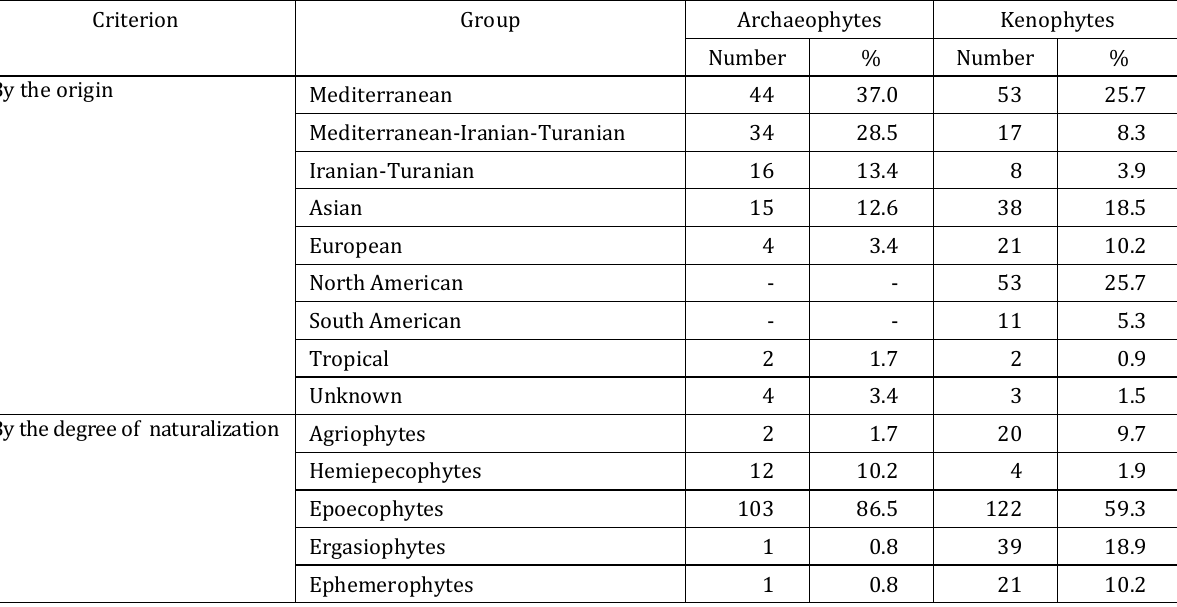
Table 2. Distribution of alien species groups in the structure of archаeophytes and kenophytes Сriterion Group By the origin